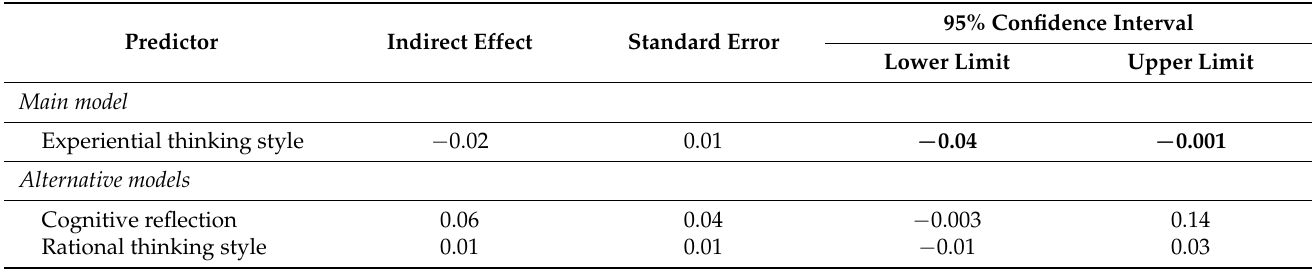
Table 3. Indirect effects from experientiality, rationality, and cognitive reflection ability towards vaccination behavior, via vaccination